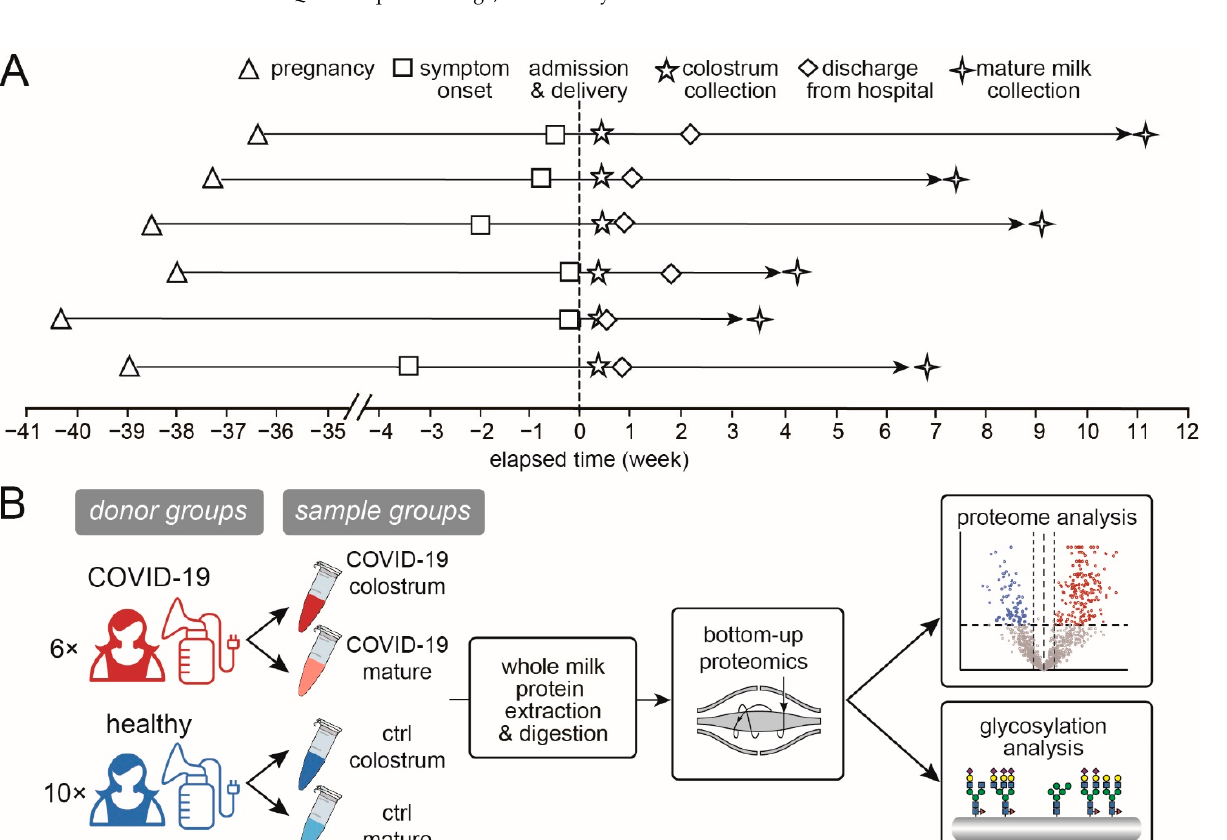
Table 1. Clinical characteristics of sample donors.